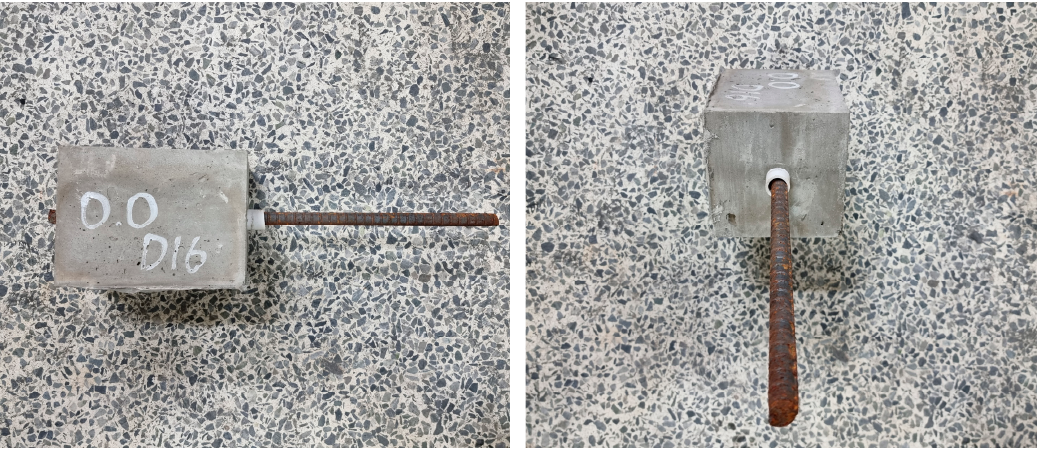
Figure 7. Pull-out test failure observed after the test.